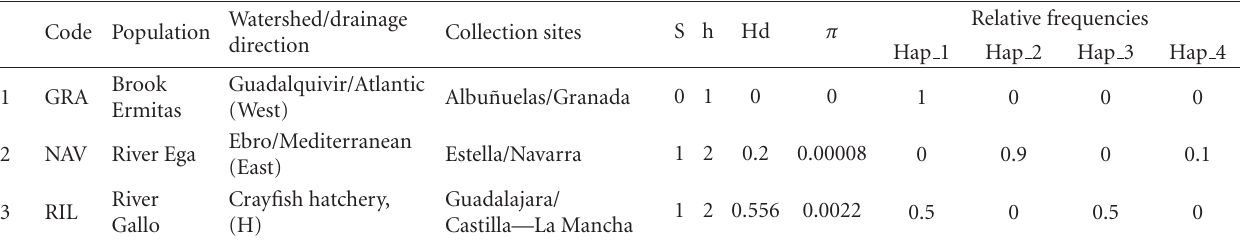
Table 1: Collection sites and genetic variability of A. italicus populations studied in the present work. Columns show, respectively, Code, Population, Watershed, Drainage Direction, and Collection sites they come from, H: hatchery. S: number of segregating sites; h: number of mtDNA haplotypes found; Hd and π : haplotype and nucleotide diversity, respectively. Last four columns refer to relative frequencies of haplotypes found in each